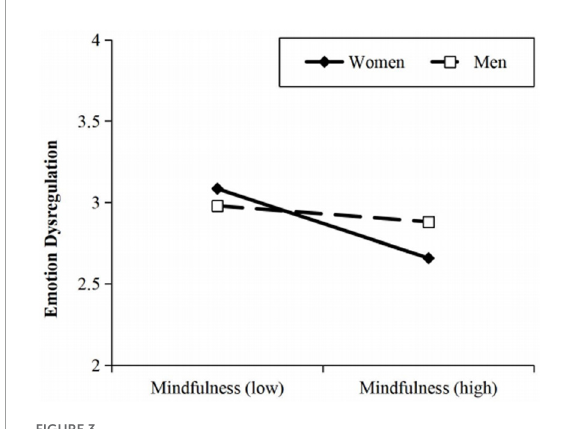
FIGURE3 Moderating effect of gender on the relationship between mindfulness and emotion